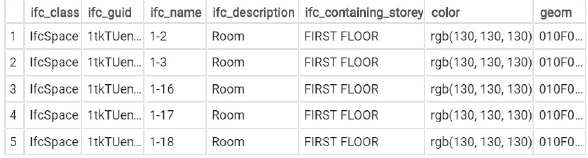
Figure 5. Example of a table created in PostgreSQL to store a IFC model.